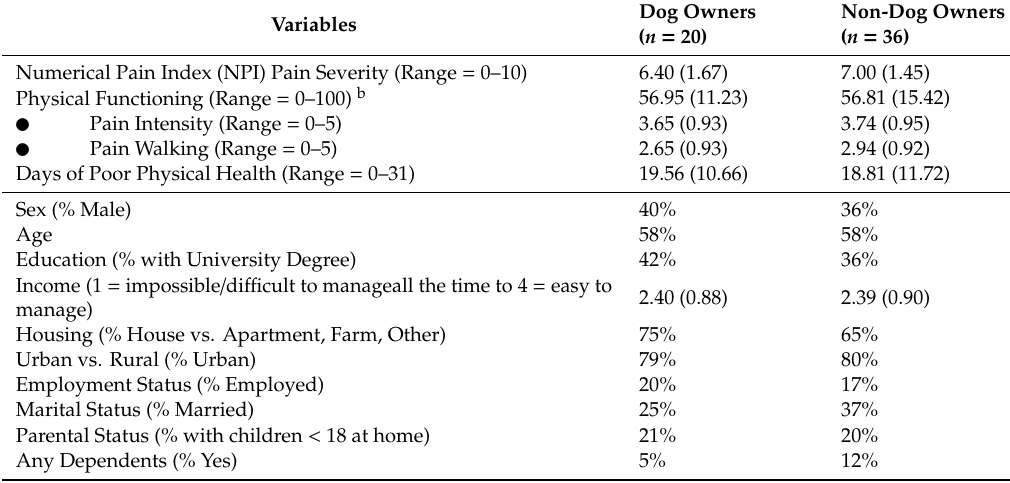
Table 1. Comparison of Dog Owners ( n = 20) versus Non-Dog Owners ( n = 36) by Pain Severity, Physical Functioning and Demographic Characteristics a